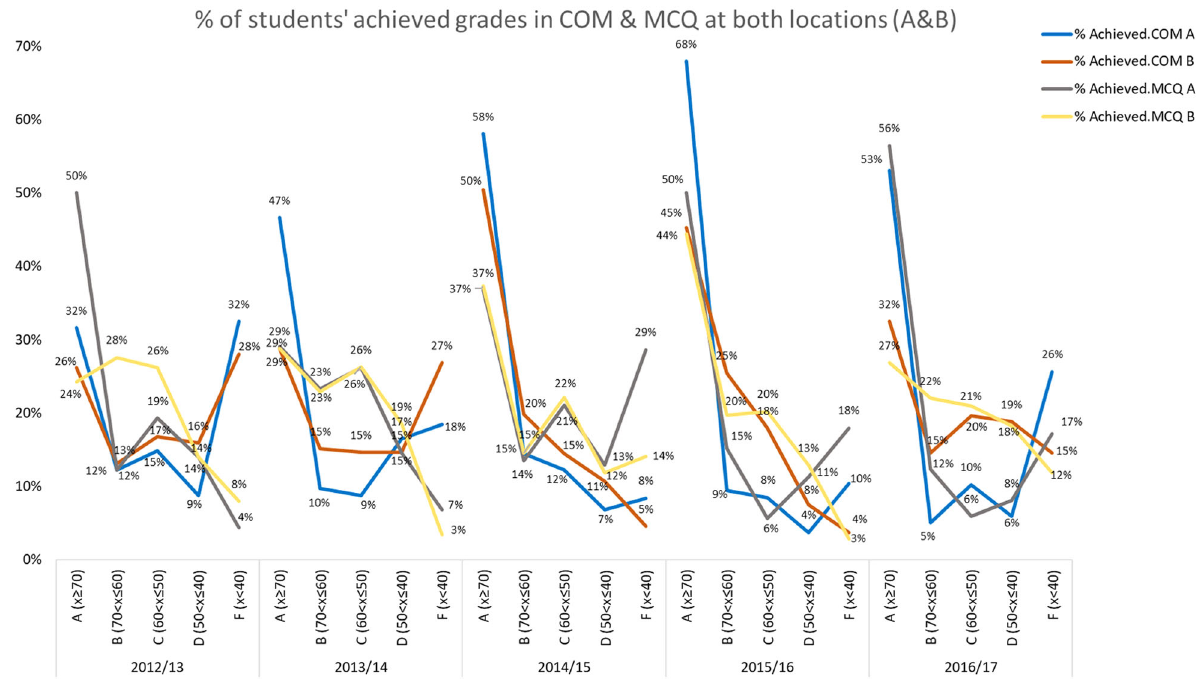
Fig. 3 Percentage of students ’ achieved grades for COM & MCQ assessments for academic years 2013/14 to 2016/17. Note: “ % Achieved ” in Figure represents the proportion of students ’ achievements within each grade in each element (COM and MCQ) at each location (A and B). Academic year 2013/ 14 served as a pilot study in which Location A engaged with the VBL (experimental group) and Location B acted as a control group with no VBL engagement. “ Good degrees ” are represented by 2:1 and First-Class honours where First Class is represented as A whilst 2:1 represented as